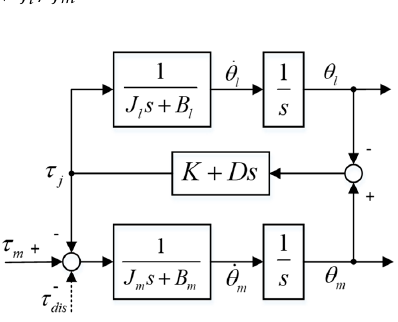
Figure 3. Modular drive joint frequency responses: ( a ) from τ m to